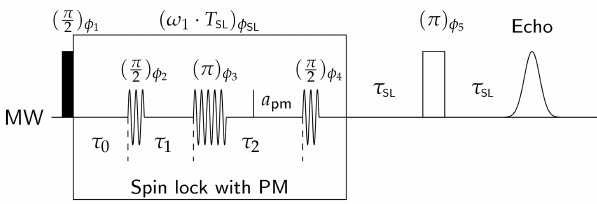
Figure 1. Pulse sequence used to measure the dipolar coupling dur- ing a spin lock. Note that | φ SL − φ 1 | = π/ 2. The phases φ 2 − 4 cor- respond to φ PM in Eq. (13), while φ SL = φ 0 in the same equation. Details for the inner working of the sequence are given in the main